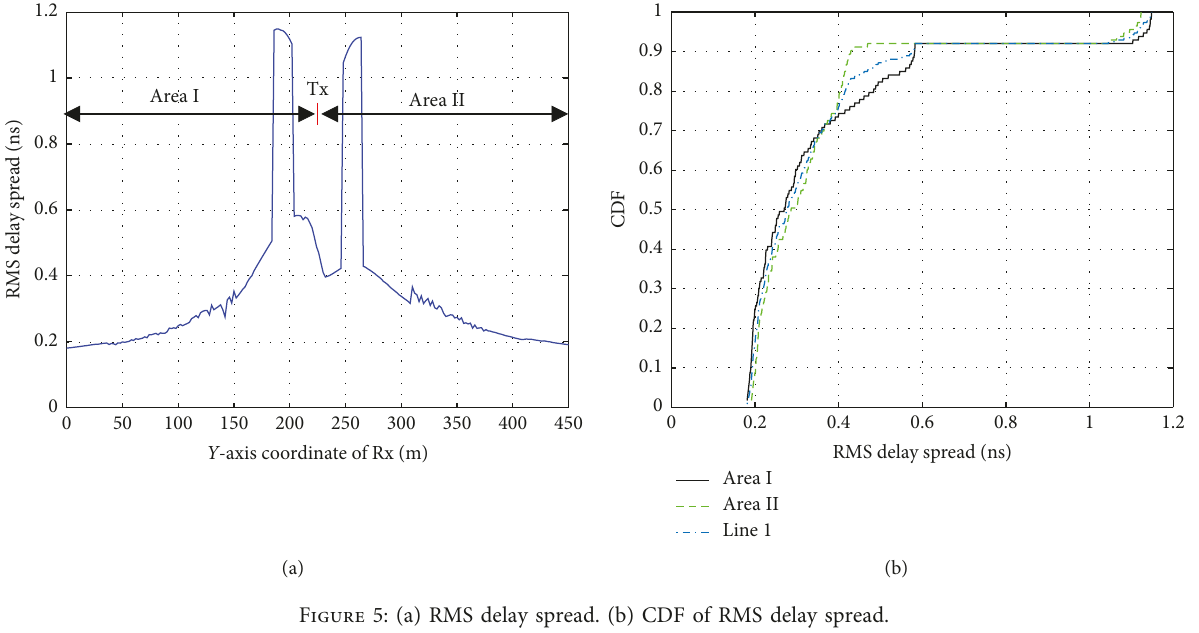
Figure 5: (a) RMS delay spread. (b) CDF of RMS delay spread.